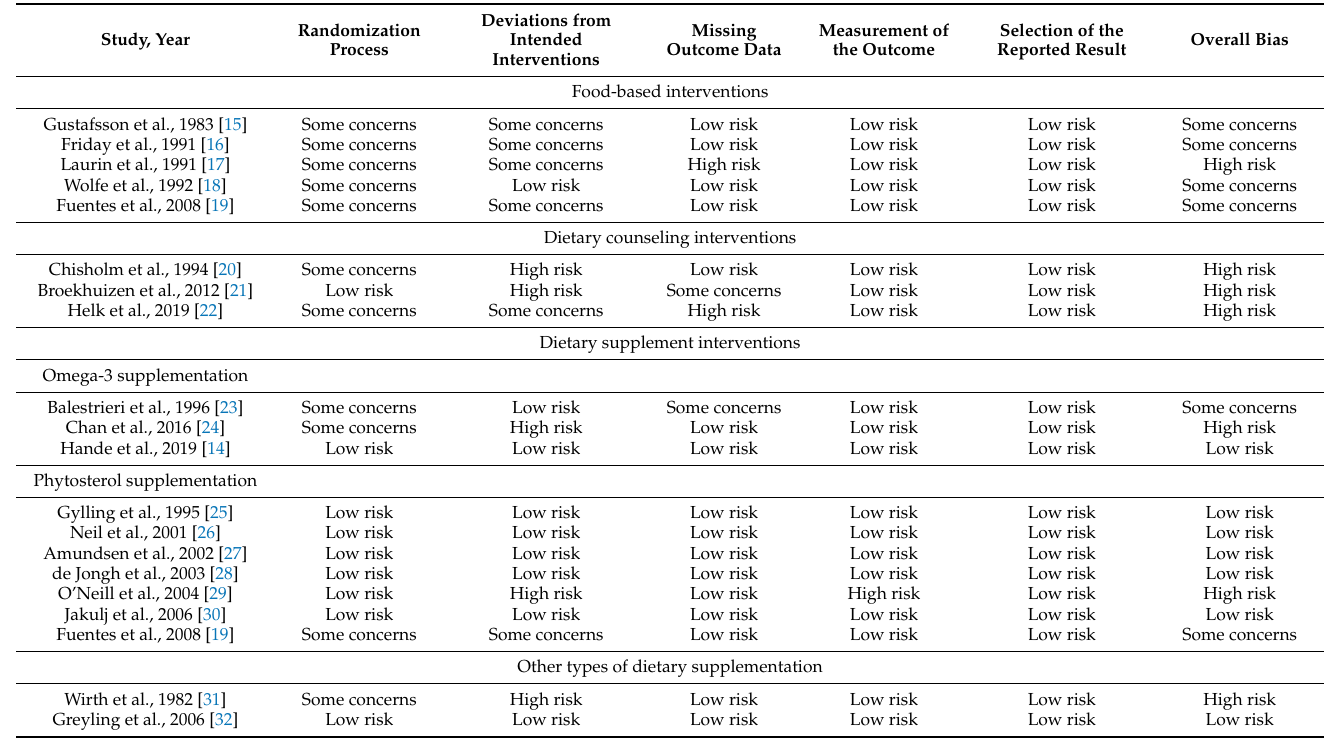
Table 2. Assessment of the risk of bias of included